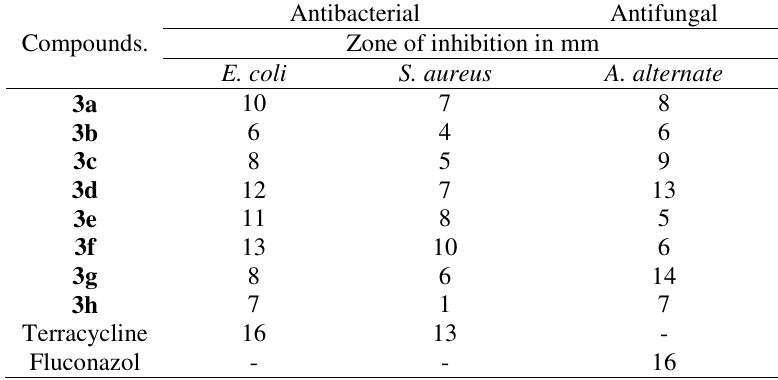
Table 2. Antimicrobial activity of synthesized compounds ( 3a-h )